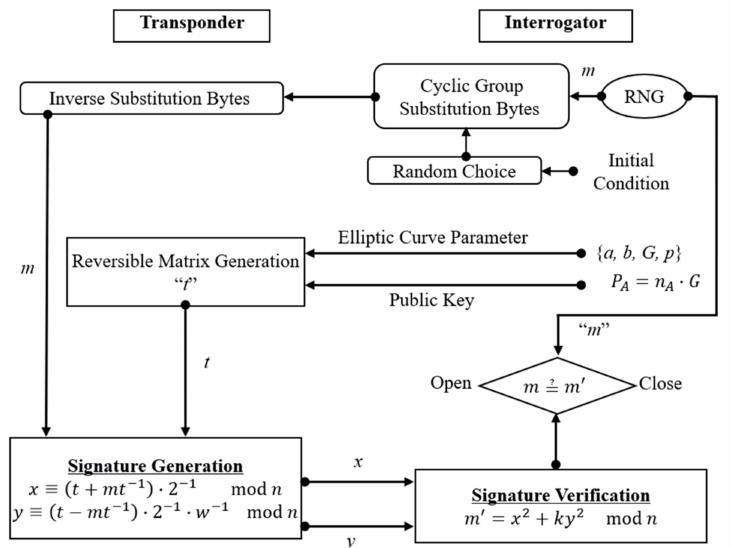
Figure 5. The proposed OSS digital signature flowchart based on elliptic curve cryptography